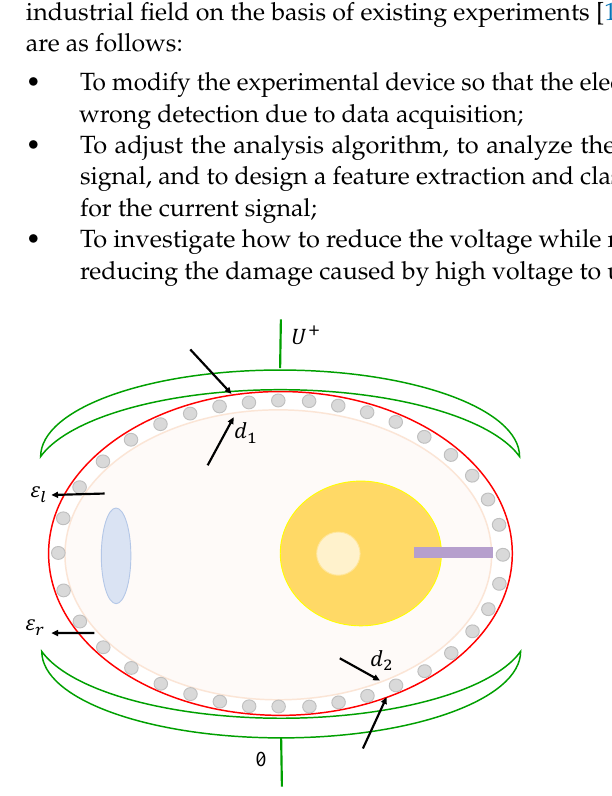
Figure 1. Schematic diagram of capacitor system composed of electrode and egg body in poultry egg crack detection method based on egg electrical characteristic model [14]. d 1 and d 2 represent the thickness of the upper and lower layers of the eggshell; ε l represents the dielectric constant of egg liquid; and ε r represents the relative dielectric constant, which represents the dielectric or polarization physical parameter of the dielectric